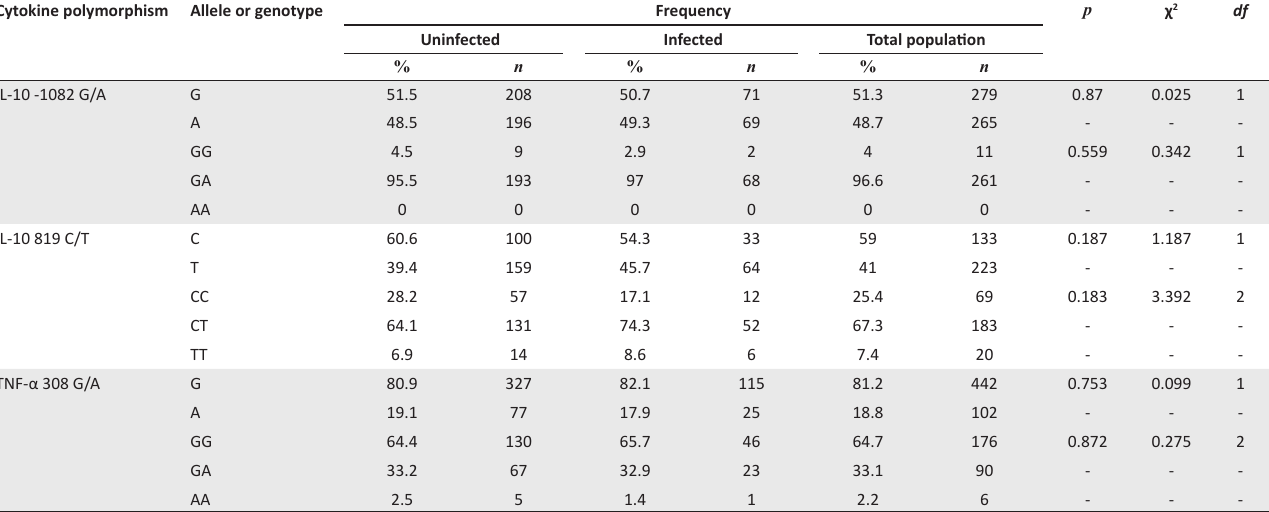
TABLE 5: Distribution of the interleukin-10 -1082, interleukin-10 819 and tumour necrosis factor alpha genotypes and alleles frequencies in uninfected and infected Schistosoma haematobium groups in the total study population. Cytokine polymorphism Allele or genotype Frequency p χ